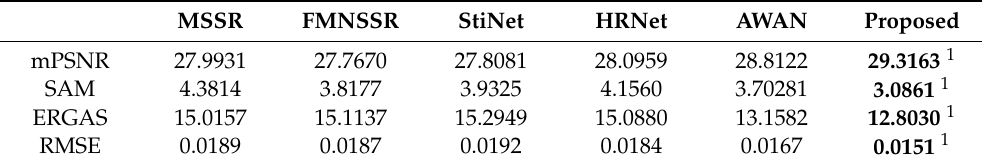
Table 4. Quality assessment comparison on GF5 data.